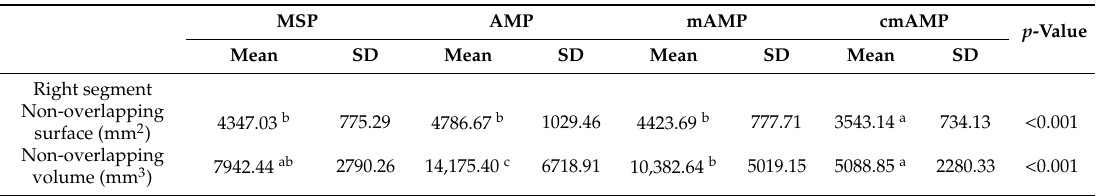
Table 2. Non-overlapping surface, volume, and similarity index (SI) using a mirroring technique based on each plane before